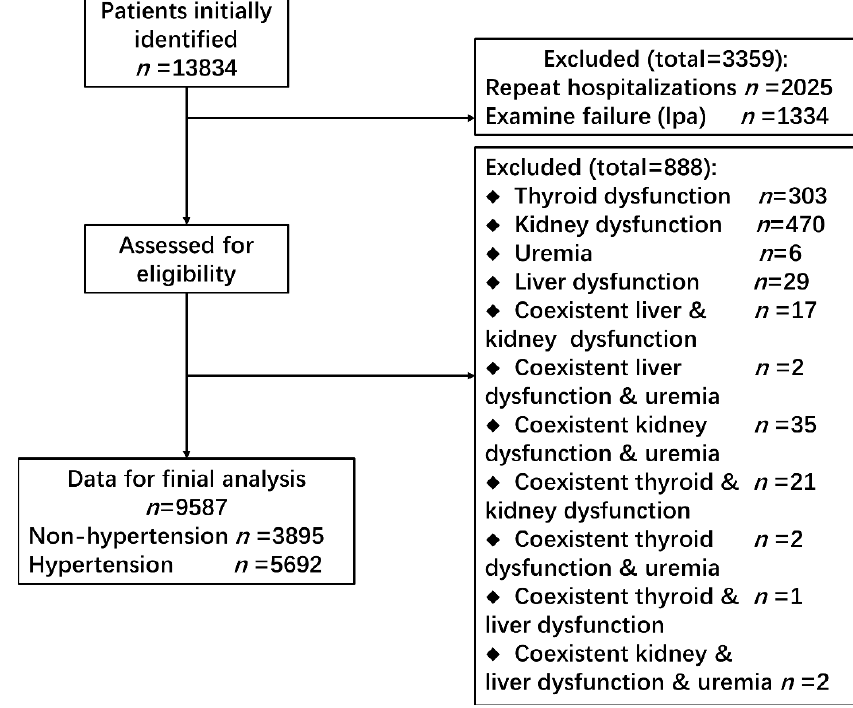
Figure 1. Flow diagram of patient selection.